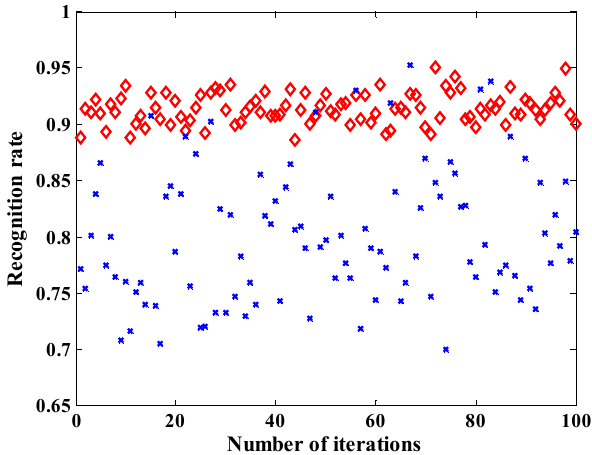
Figure 9. Training and testing both the SNN and EBA with defect in a transformer.